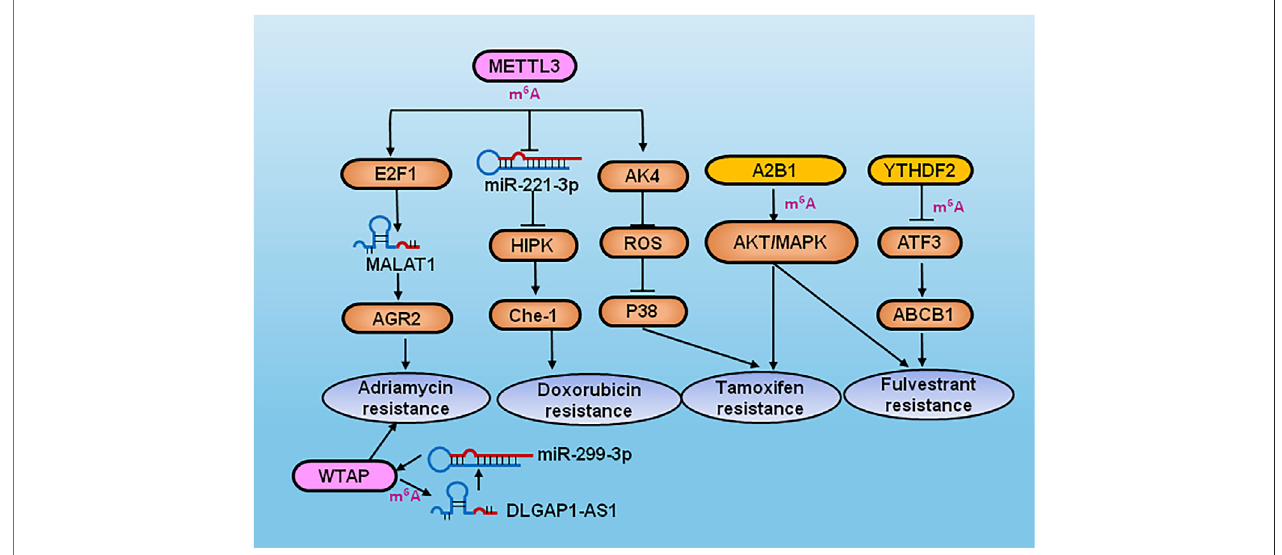
FIGURE3| DiagramofRNAmodi fi cationregulatorsinducingdrugsresistanceinbreastcancer.METTL3increasedtheexpressionofMALAT1toactivateAGR2by recruiting E2F1 and subsequent adriamycin resistance in breast cancer. METTL3 also promoted maturation of miRNA-221-3p in a m 6 A-dependent manner and negatively regulated HIPK2 and upregulated Che-1 which induced chemoresistance of breast cancer cells to doxorubicin. METTL3 promoted tamoxifen resistance by promoting AK4 expression, reducingthe production ofROS and decreasing the activity ofp38. WTAP binds toDLGAP1-AS1 and sponged miR-299-3p toconfer adriamycinresistanceinbreastcancer.A2B1inducedtamoxifenandfulvestrantresistancebyAKT/MAPKsignalingpathways.YTHDF2downregulatedATF3toactivate ABCB1, resulting in tamoxifen resistance of breast cancer.